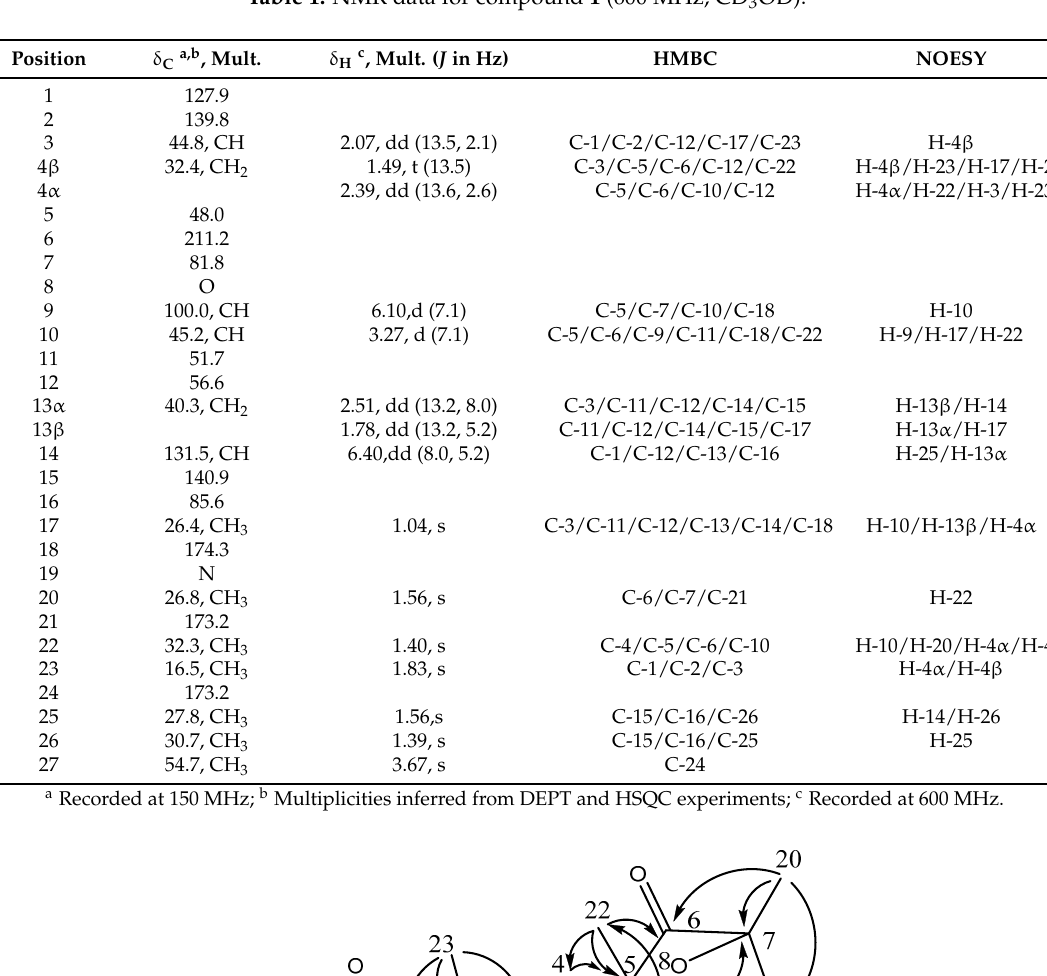
Table 1. NMR data for compound 1 (600 MHz, CD 3 OD).